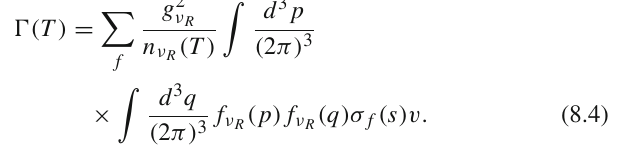
of the right-handed neutrinos to (cid:8) N ef f as a function of M (cid:2) horizontal dashed red line represents the current upper bound on the shift on the N ef f